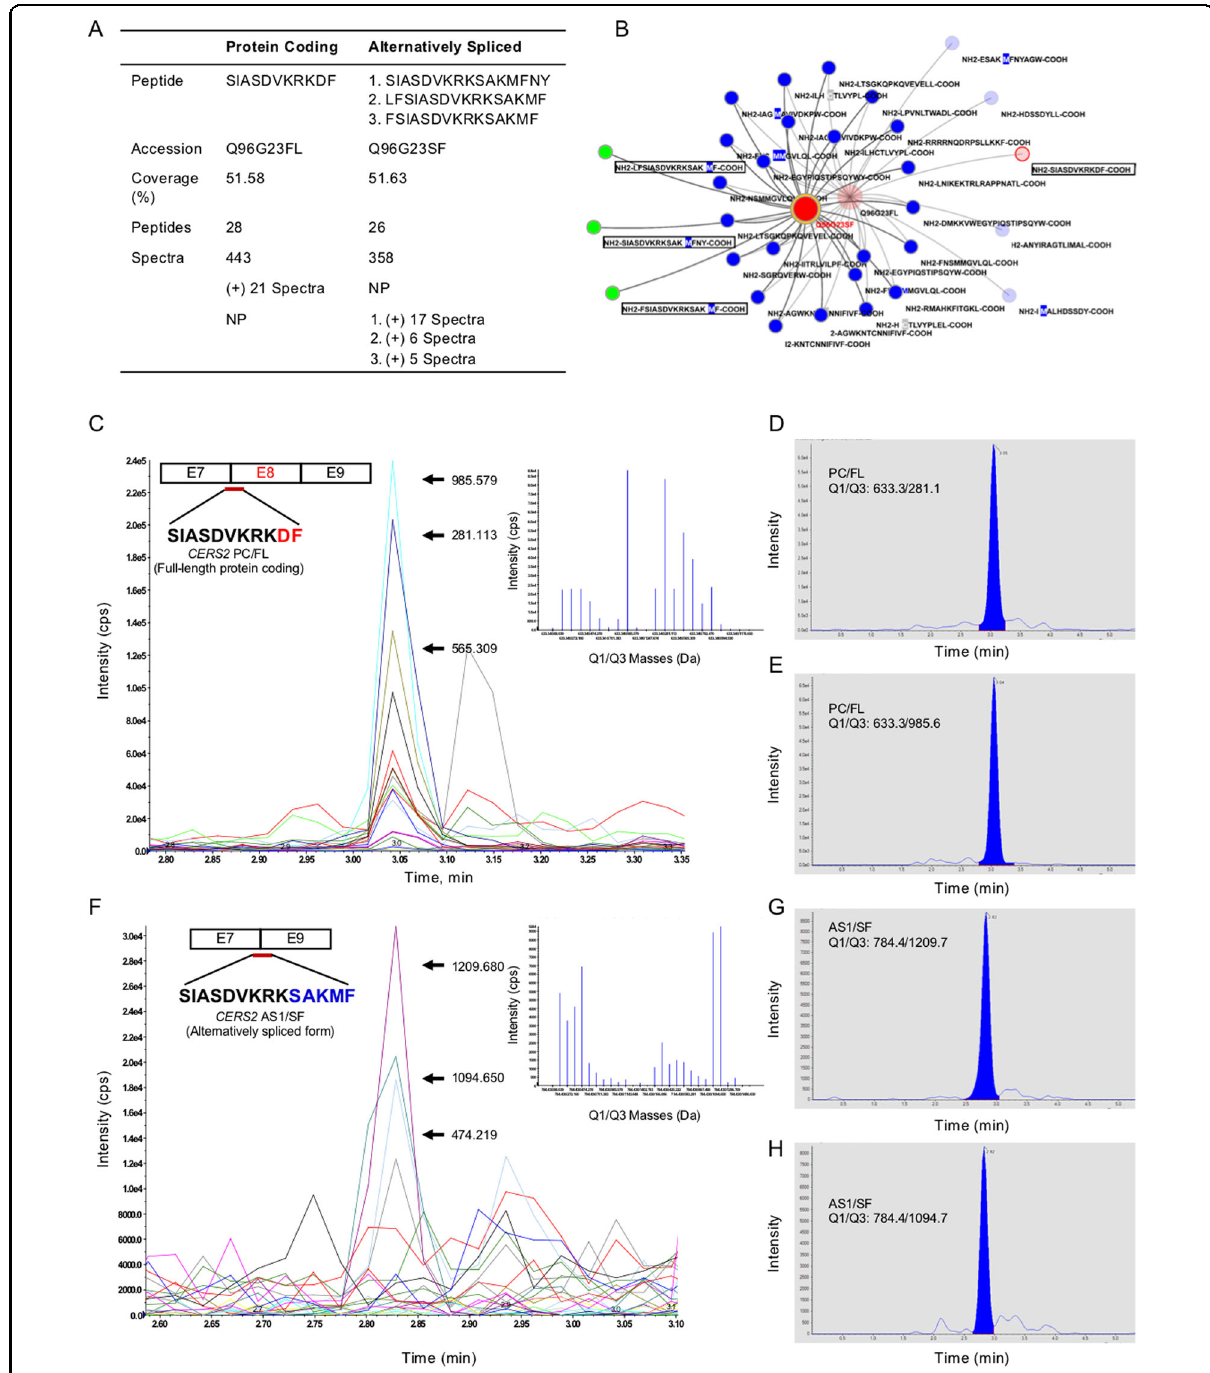
Fig. 4 (See legend on next